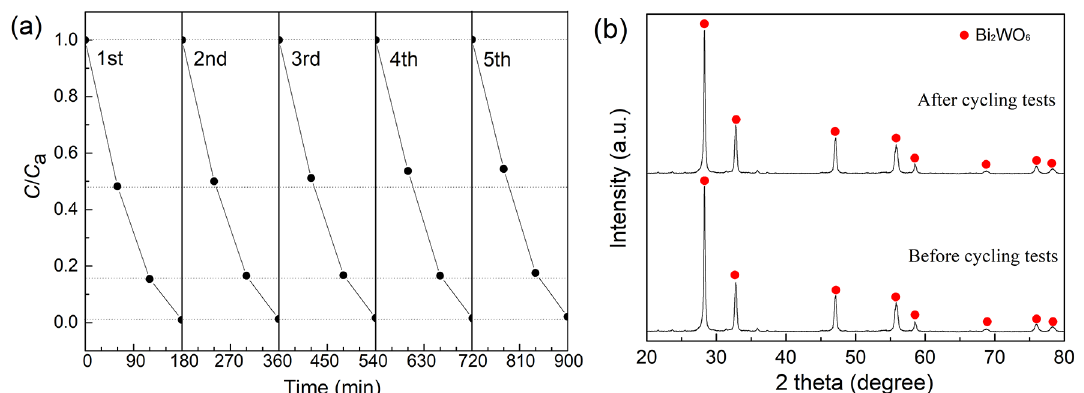
WO powders before and after 5 times cycling 2 6